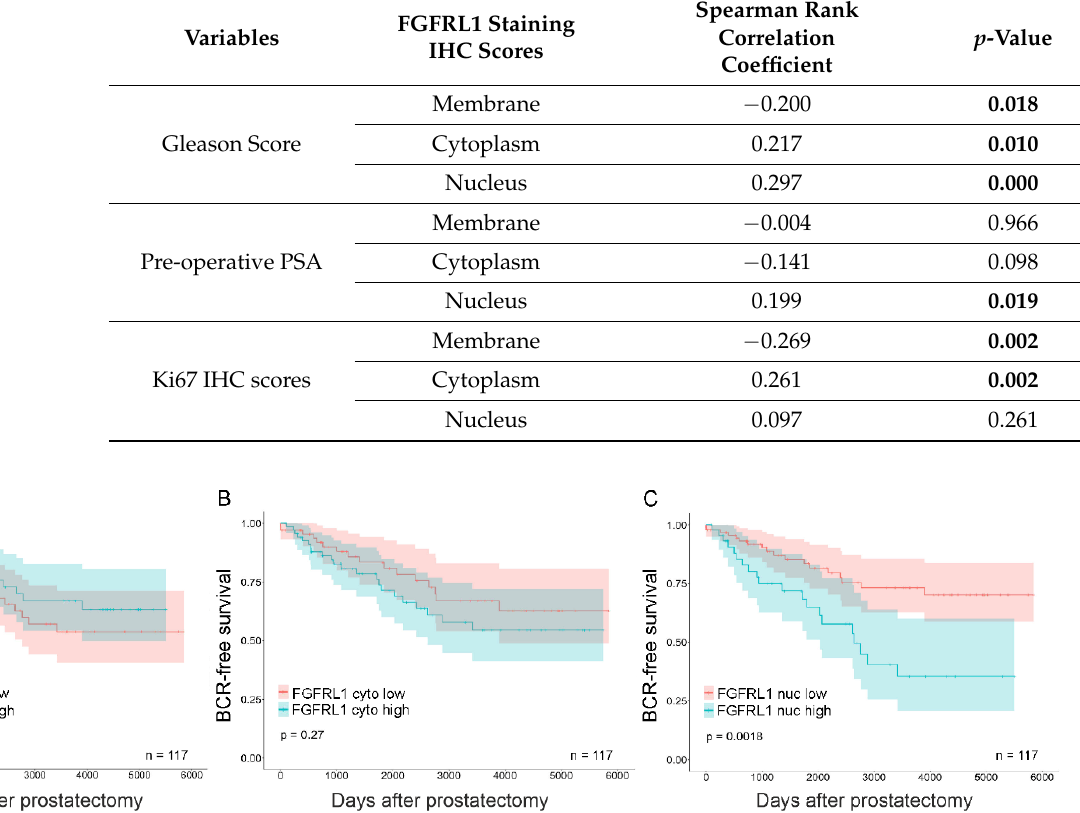
Table 1. Correlation of FGFRL1 staining with the Gleason score, pre-operative PSA, and Ki67 expression (Spearman rank correlation).